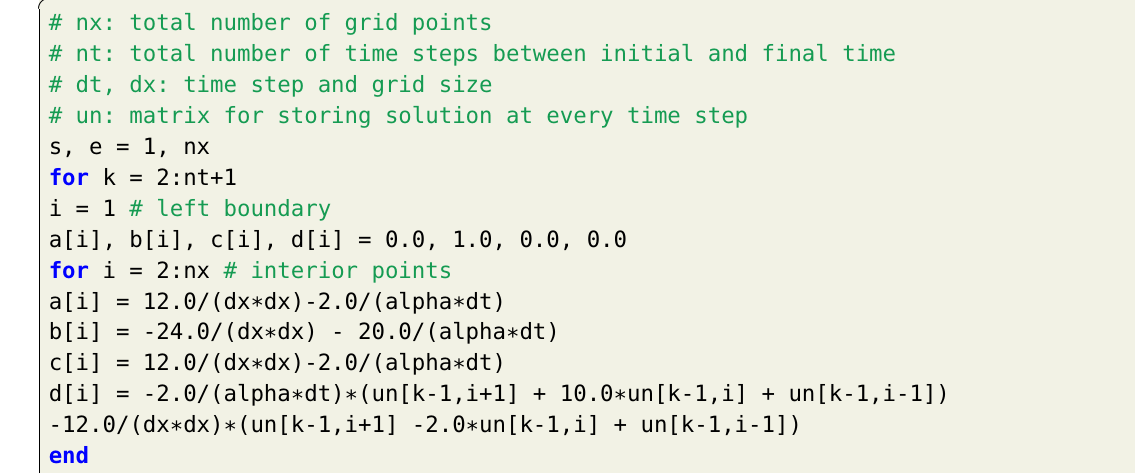
Listing 5. Implementation of implicit compact scheme Pade numerical scheme for heat equation in Julia.